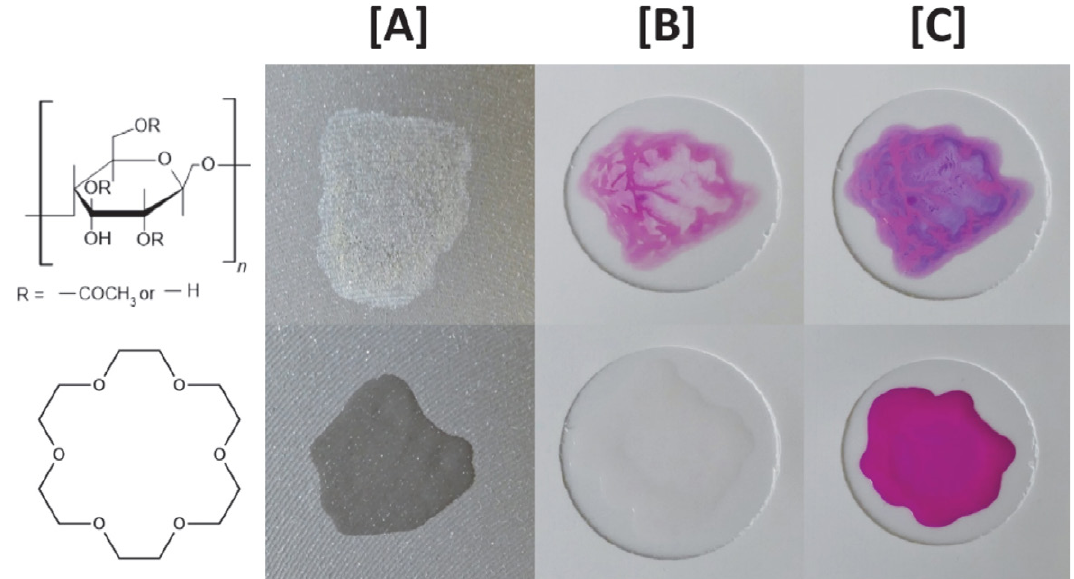
Figure 2: The non-modified (the upper row) and the modified 15% ether 18-crown-6 acetyl cellulose film (the lower row) are compared. The natural appearance of the polymer film after the evaporation of the dissolving agent [A], the excluded polymer film with the benzimidazole-rhodamine agent [B], and after being exposed to diphosgene vapours [C] are presented.